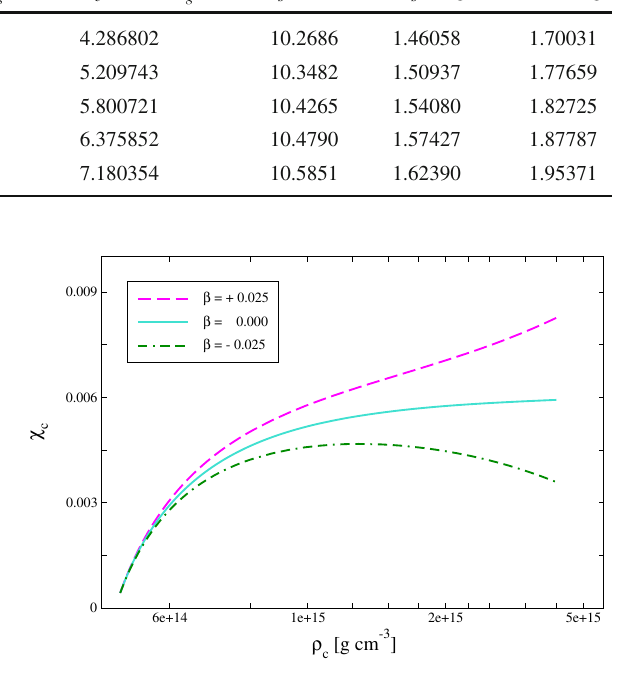
Fig. 9 Central value of Ricci scalar χ c ( = Rr 2 g ) versus central density ρ β , namely, β = ± 0 . 025 and β = 0 c for different values of